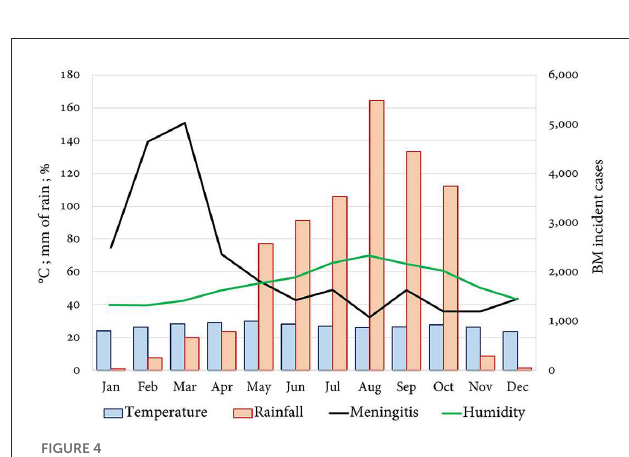
Report of incident cases and meteorological variables per month in the